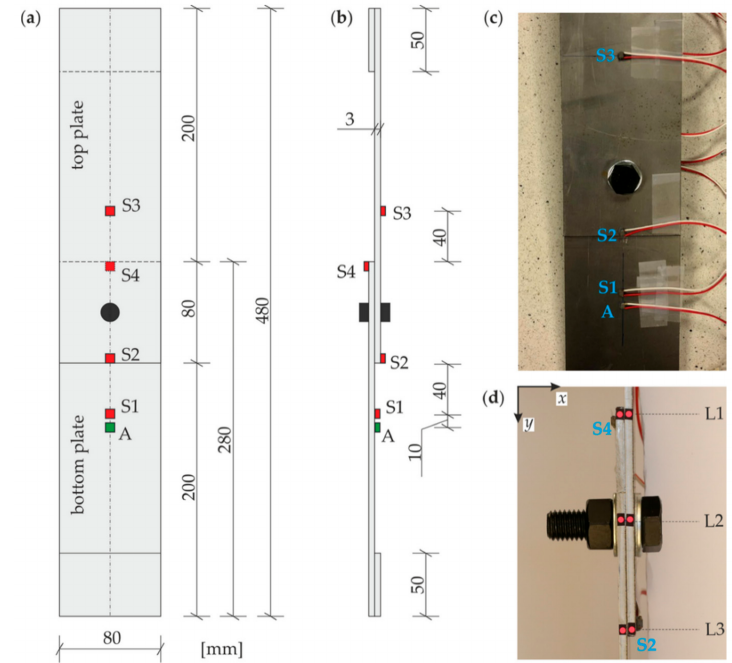
Figure 1. Geometry of the investigated bolted joint with indicated locations of piezoelectric transducers: ( a ) plane view; ( b ) side view; and photographs of the joint with attached piezoelectric transducers for ultrasonic measurements ( c ) and markers for optical displacement measurements ( d